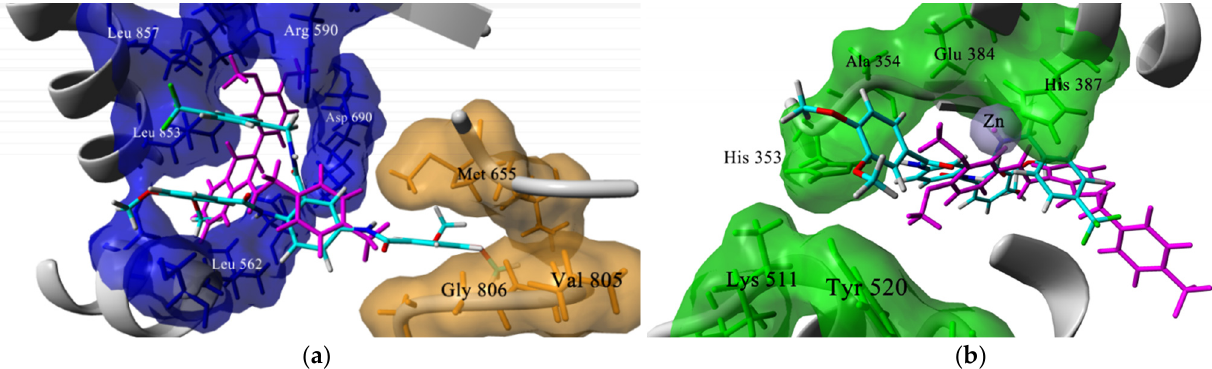
Figure 4. Predicted docking poses for compound 48a (magenta) and 1b (CPK, carbon atoms in cyan) in their complexes with ( a ) HMG-CoA reductase; ( b ) angiotensin-converting enzyme (ACE). In Figure 4a, blue- and orange-colored residues correspond to the HMG-CoA and NADP-binding sites, respectively.